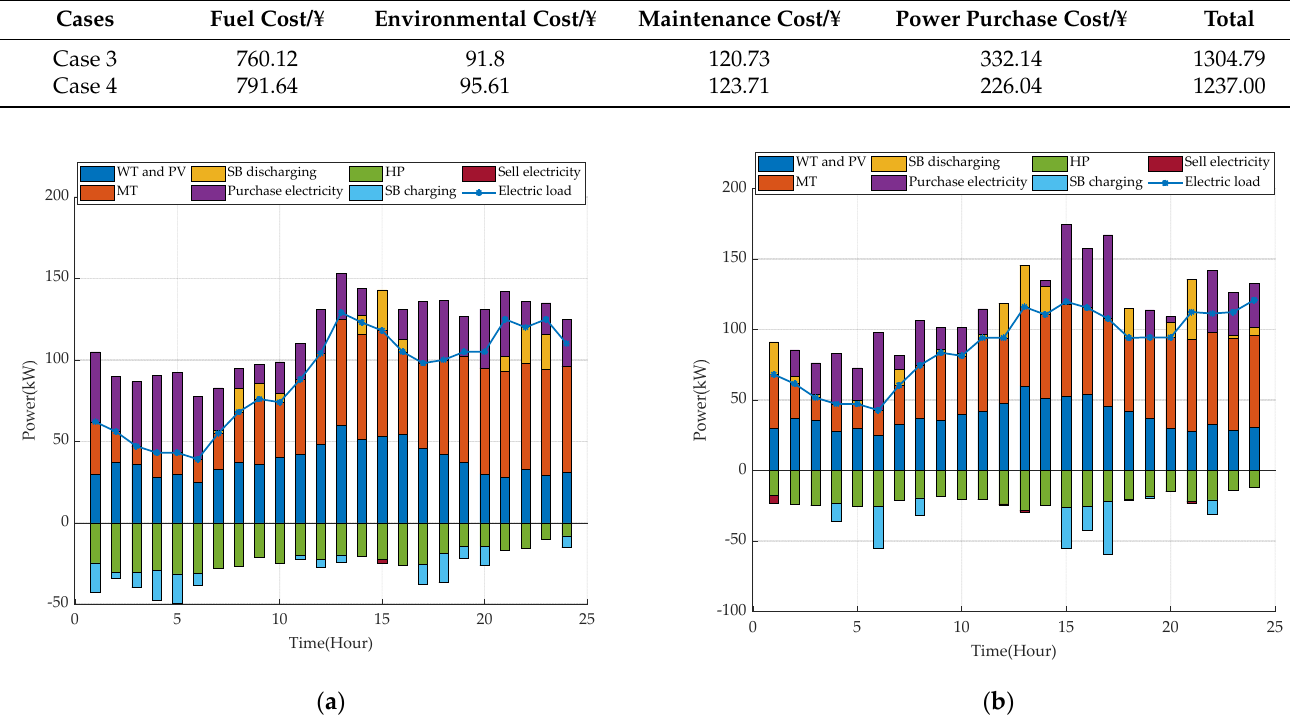
Figure 5. Economic dispatch results in summer: ( a ) Case 3 and ( b ) Case 4.